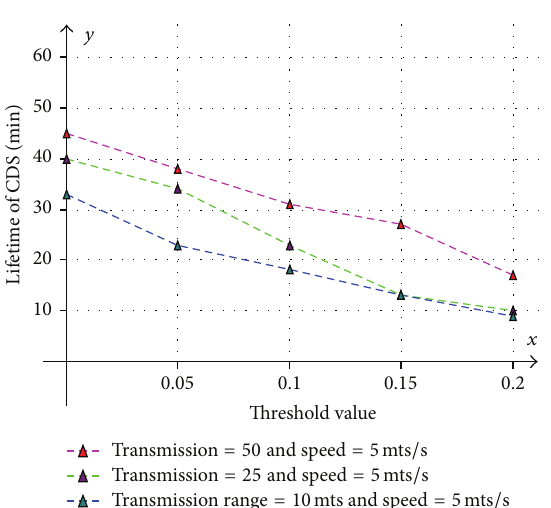
Figure 15: Lifetime of CDS (min) versus energy threshold values.